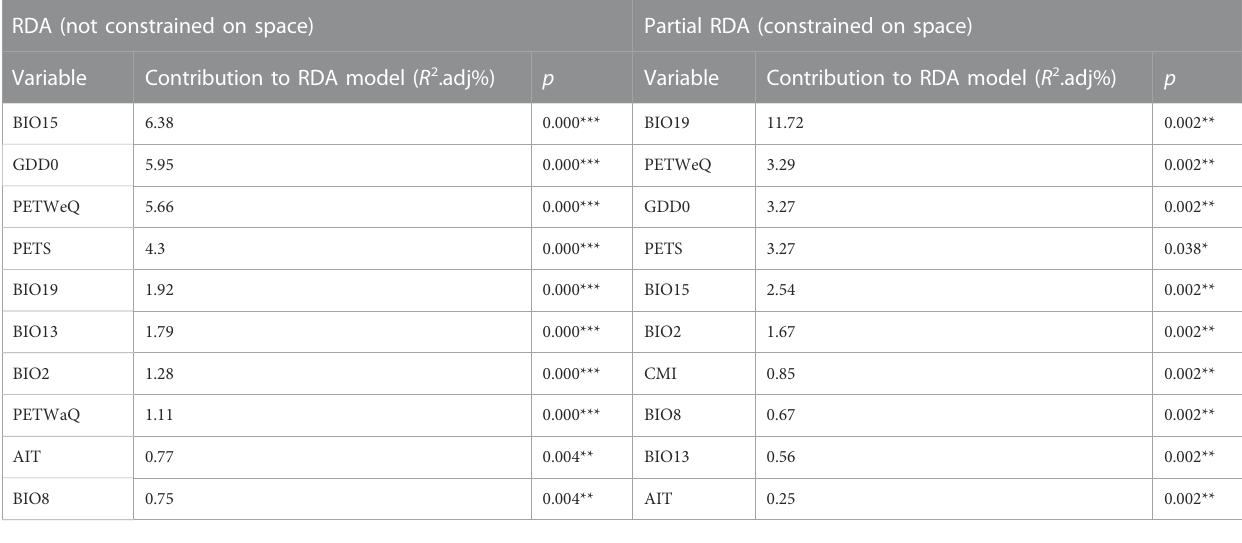
TABLE 1 Climate variables retained by forward selection and their contribution to genomic SNP variation using RDAs. The climate variable de fi nitions are in Supplementary Material. RDA (not constrained on space)